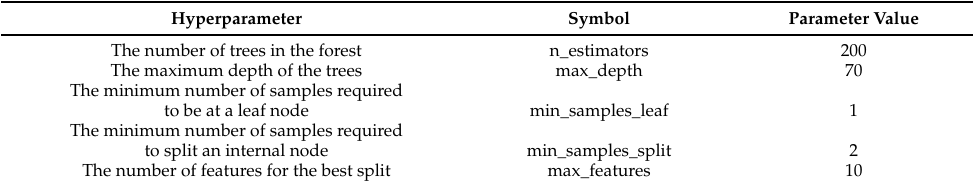
Table 3. Main hyperparameters for Random Forest